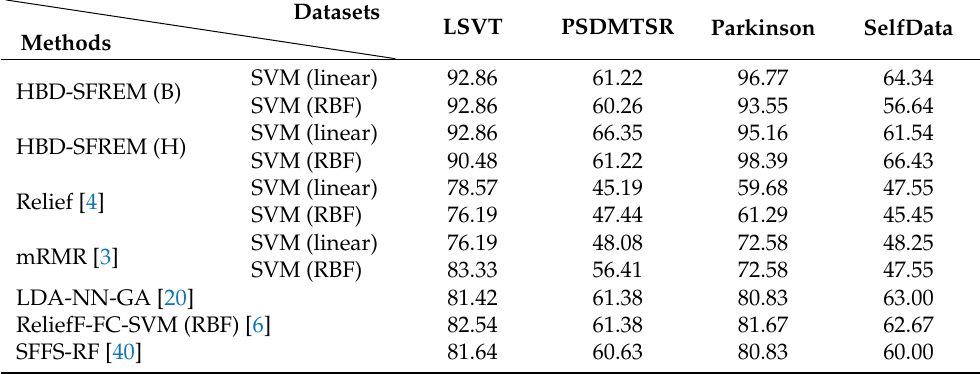
Table 8. Comparison of PD speech dataset processing algorithms